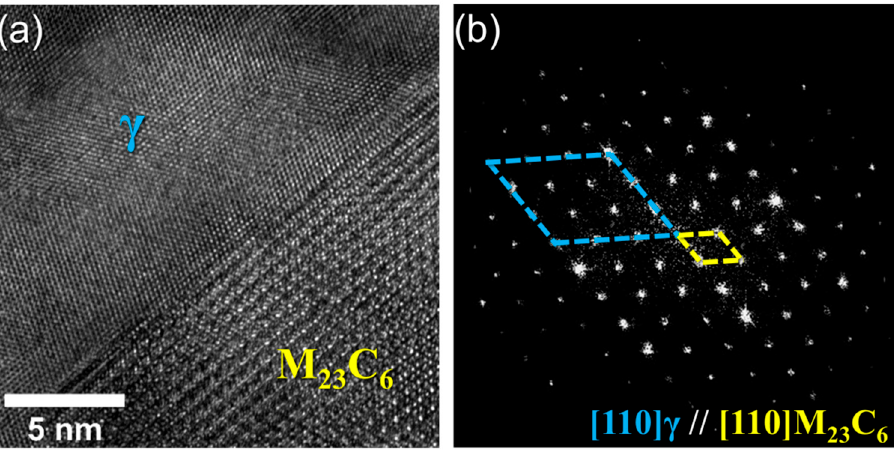
Figure 5. ( a ) High-resolution TEM images taken at the γ -M 23 C 6 interface in the HC-1 sample and ( b ) corresponding fast-Fourier transformation results.